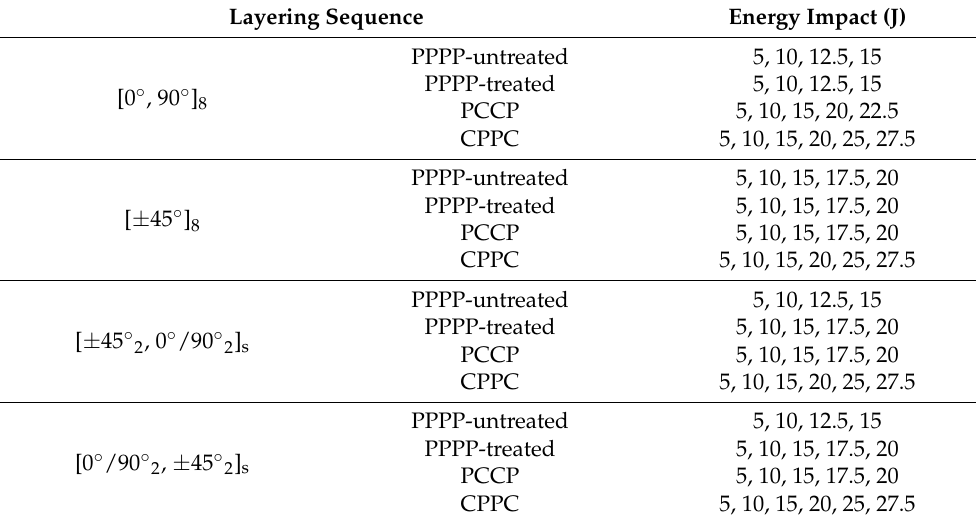
Table 3. Energy levels used to investigate the impact of the